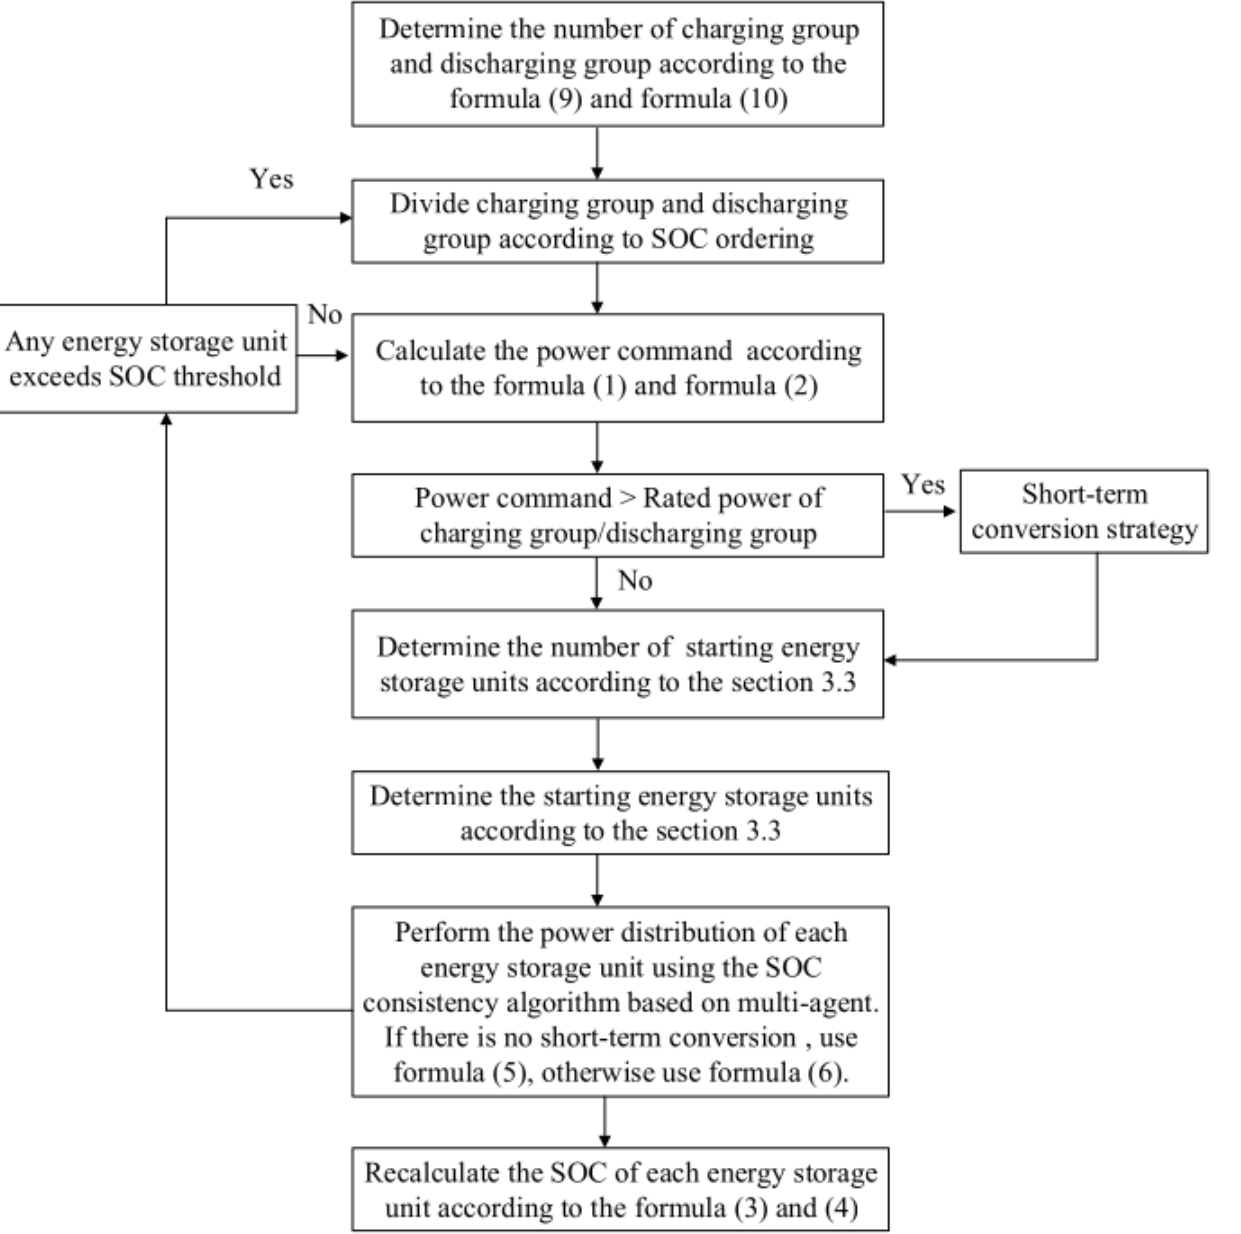
Figure 2. Flow chart of power